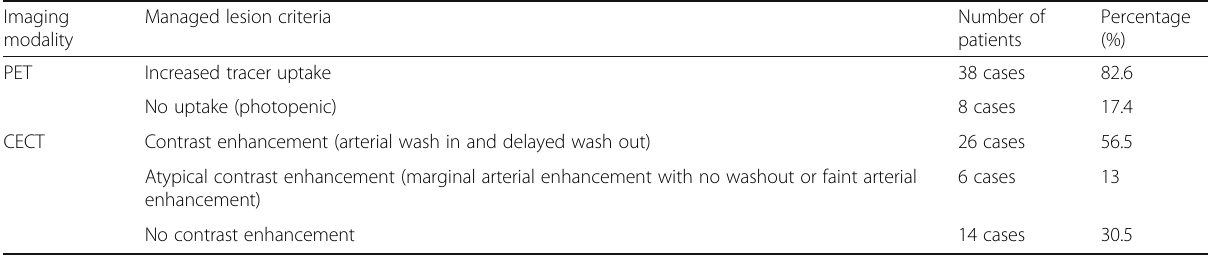
Table 1 Imaging features of the managed lesions Imaging